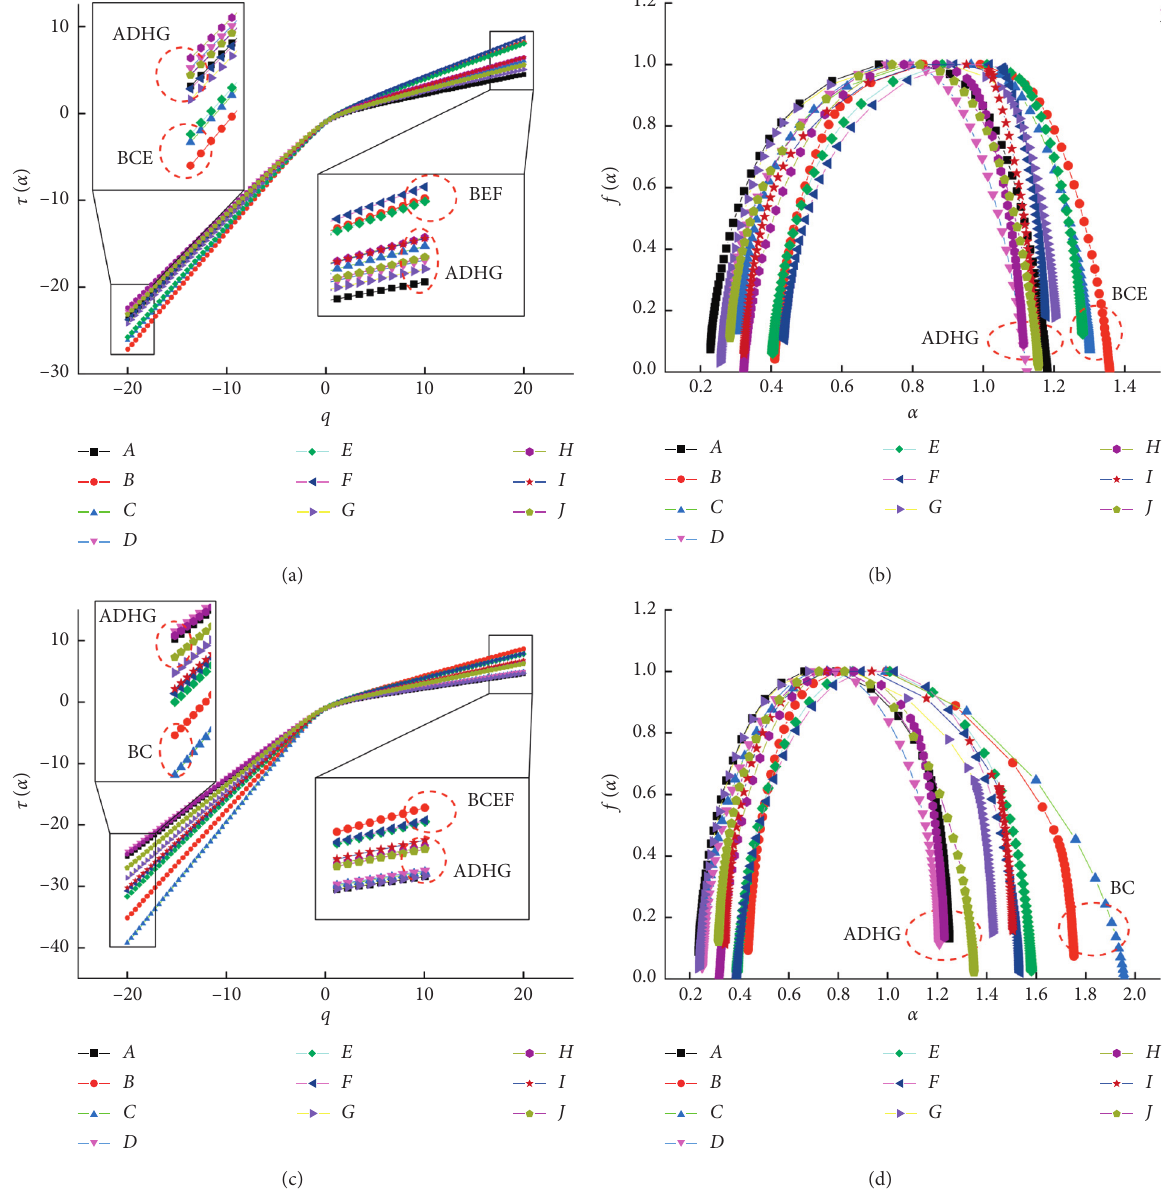
Figure 13: Multifractal characteristics of MS waveform with background noise: (a) τ ( q ) − q graph with window size of 1500ms; (b) f ( α ) − α graph with window size of 1500ms; (c) τ ( q ) − q graph with window size of 750ms; (d) f ( α ) − α graph with window size of